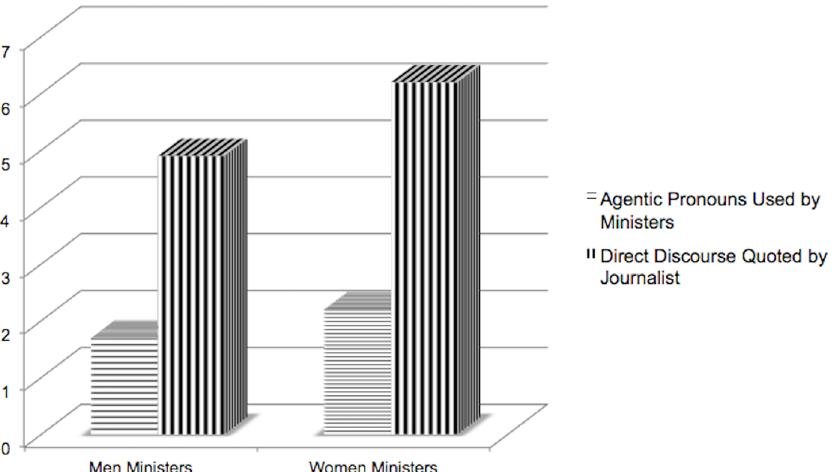
Figure 4. Agency detected by pronouns used by ministers (First Pers. Sing. and Plur.) and direct discourse quoted by journalist in the headlines, in terms of the proportion by articles published for each